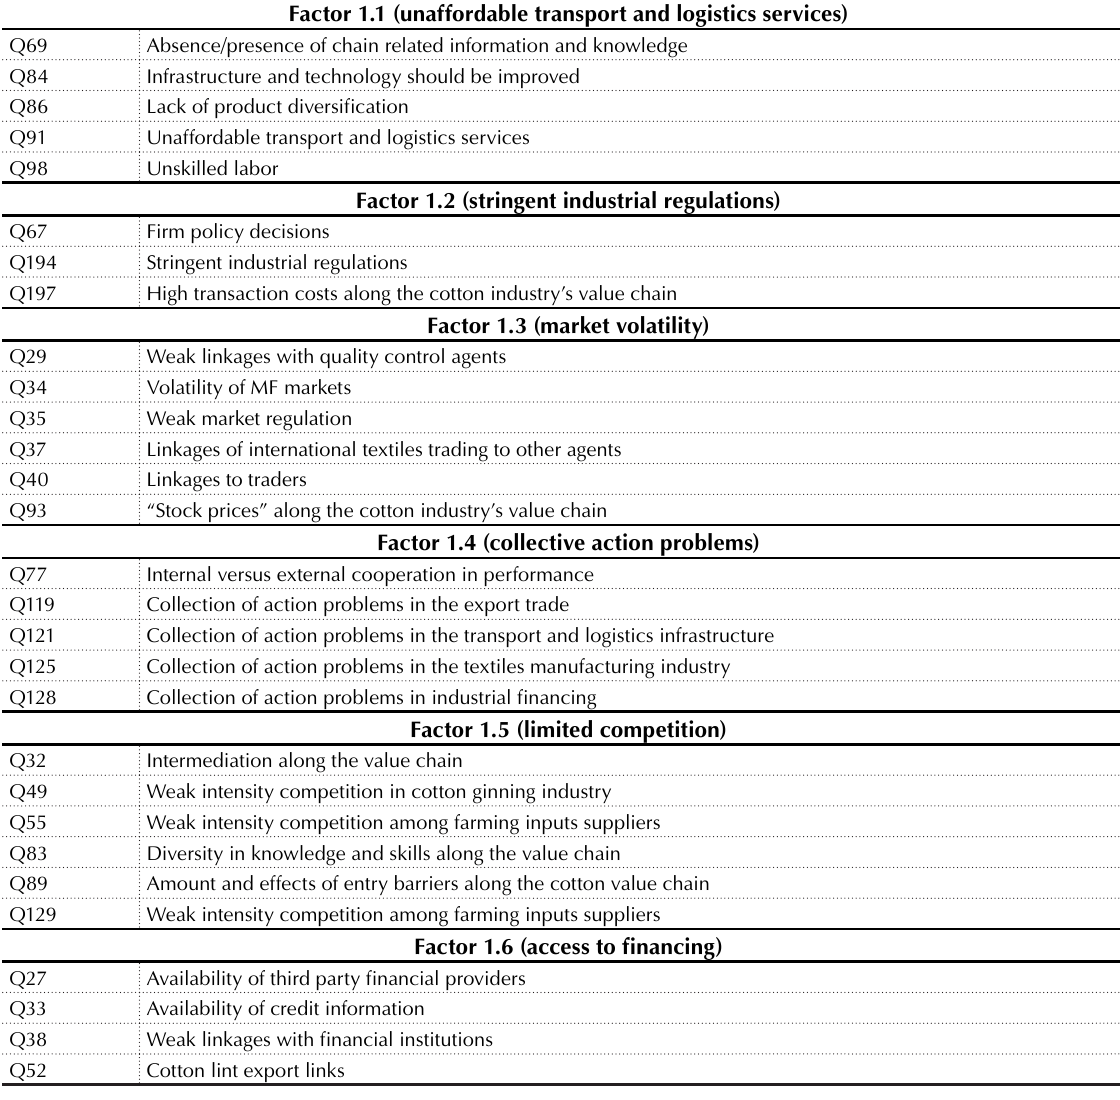
Table 6. Summary of barriers to effective and efficient VCM in the Zimbabwe cotton value